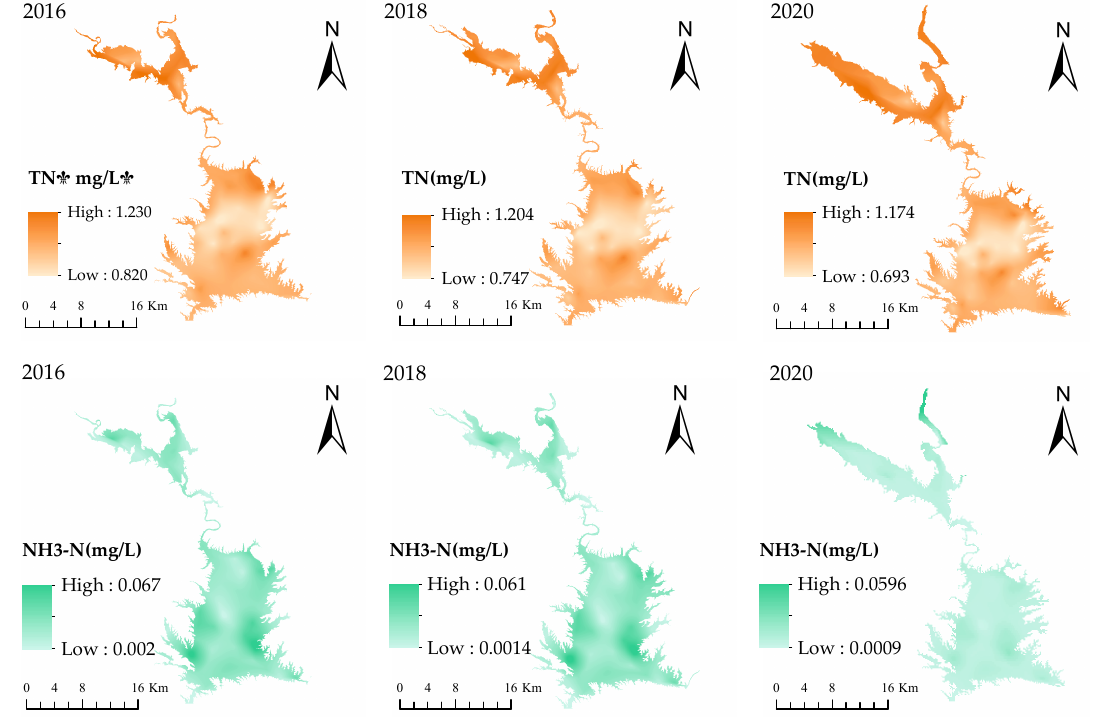
Figure 8. Temporal and spatial distribution characteristics of TN and NH 3 -N concentrations during the study